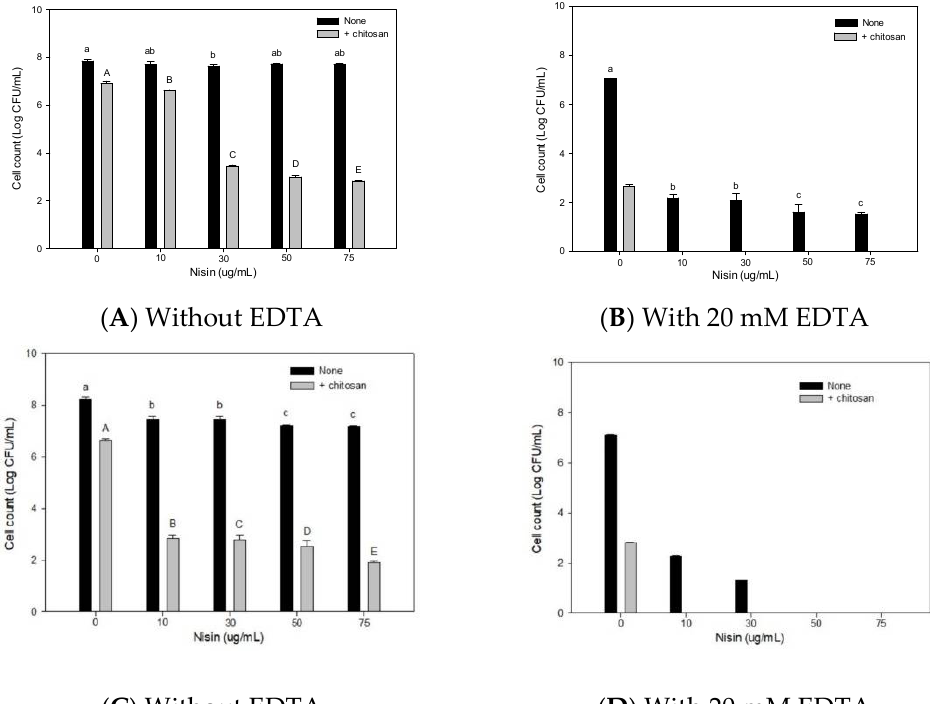
Figure 1. Antibacterial activity of chitosan (5 μg/mL) in NB broth containing various concentrations of nisin without EDTA ( A , C ) and with EDTA (20 mM) ( B , D ) against Escherichia coli BCRC11634 ( A , B ) and Staphylococcus aureus BCRC 10451( C , D ). Data were presented as mean ± SD from triplicate experiments. Different letters of upper or lowercase were significantly different ( p < 0.05).